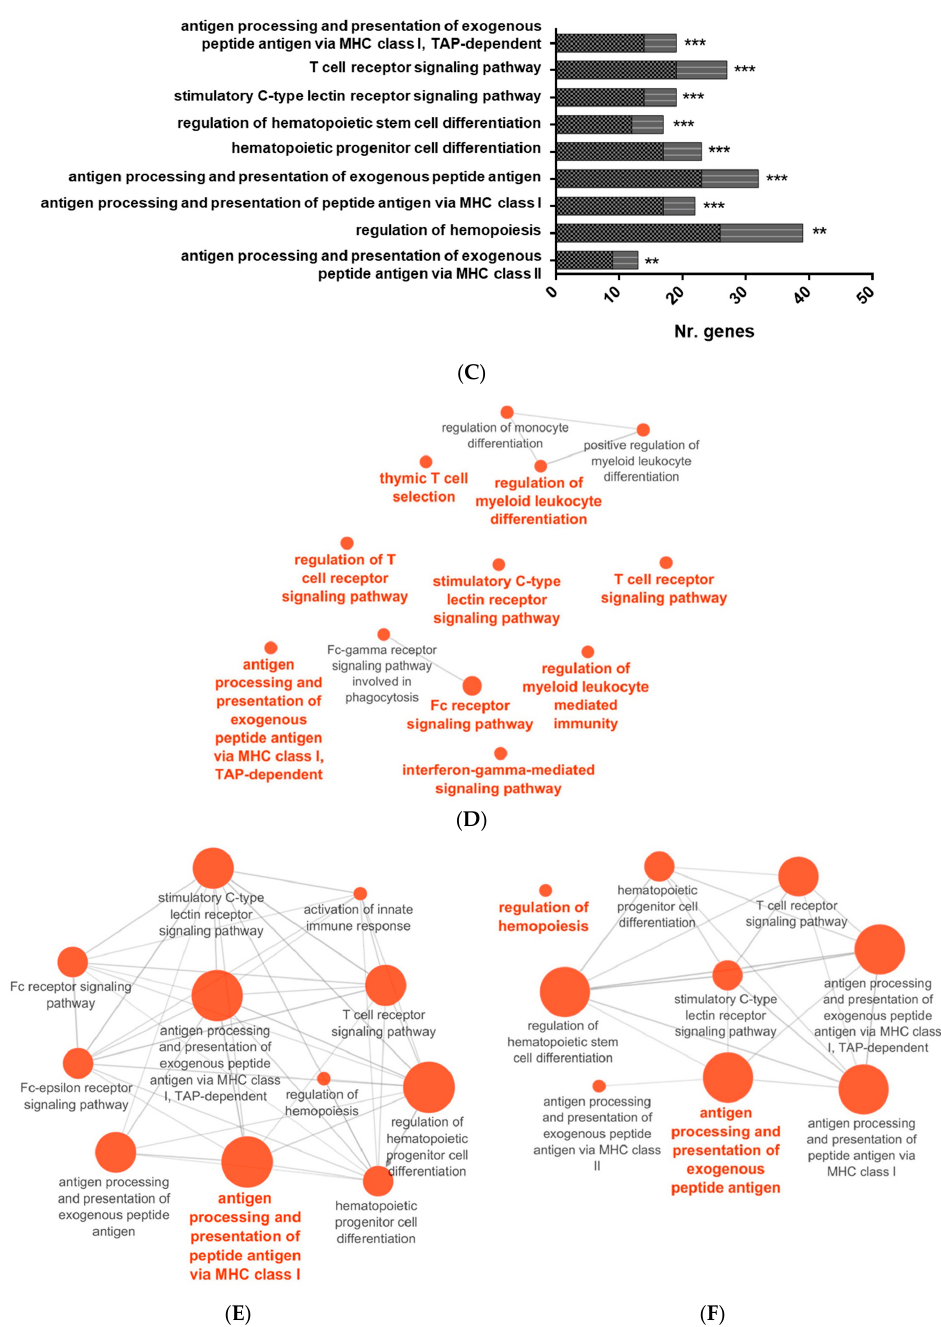
Figure 3. Overrepresented functional pathways in RBCs from GVHSV-immunized fish. Overrepresented GO Immune System Process terms were identified by the Cytoscape ClueGO. ( A ) Overrepresented pathways in the HK-RBC transcriptome profile. ( B ) Overrepresented pathways in the PB-RBC transcriptome profile. ( C ) Overrepresented pathways in the PB-RBC proteome profile. Black squares represent upregulated genes or proteins, and gray squares represent downregulated genes or proteins identified in each GO term. Asterisks denote GO-term significance: * p -value < 0.05, ** p -value < 0.01 and *** p -value < 0.001. Overrepresented terms in the GO Immune System Process network are shown in the ( D ) HK-RBC transcriptome profile, ( E ) PB-RBC transcriptome profile, and ( F ) PB-RBC proteome profile. Each node represents a GO term from an Immune System Process. Node size shows GO term significance ( p -value); a smaller p -value is represented by a larger node size. Edges between nodes indicate the presence of common genes; a thicker line implies a larger overlap. The most significant GO term for each group is